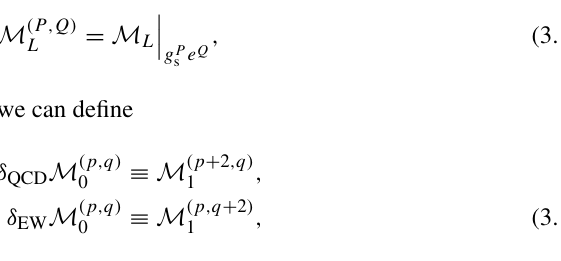
Fig. 4 Schematic representation of the towers of mixed QCD–EW terms at LO and NLO. The first row represents the LO tower (3.4)– (3.6), which consists of an alternating series of dominant squared Born terms (dark grey blobs) and sub-leading pure interference terms (light grey blobs). The second row corresponds to the NLO tower (3.14)– (3.24). EachLOtermisconnectedtotwoNLOtermsvia QCD(red)and